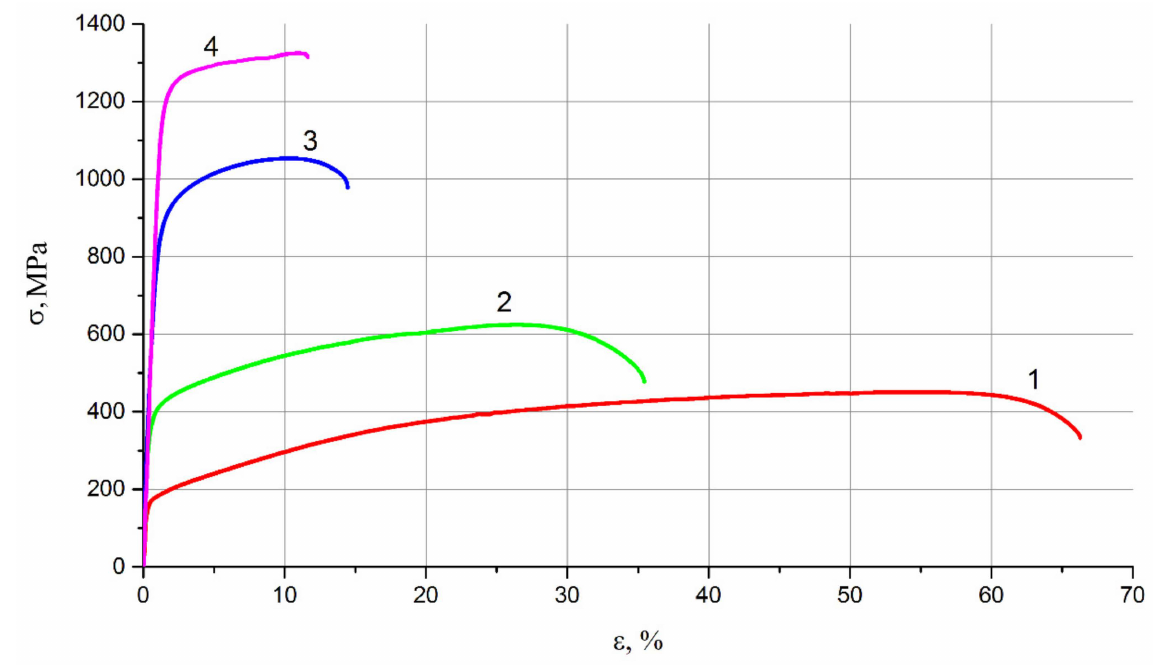
Figure 7. Tensile curves: ( 1 ) initial state; ( 2 ) after two deformation cycles; ( 3 ) after four deformation cycles; and ( 4 ) after six deformation cycles by HPT